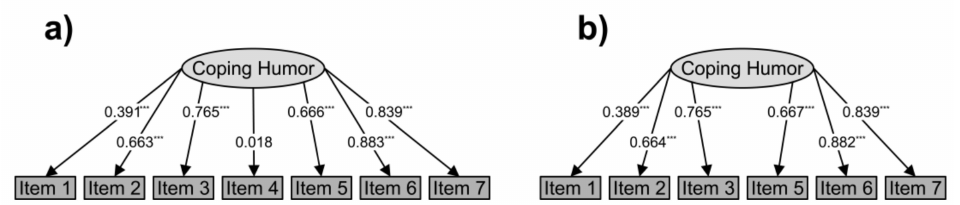
Figure 1. ( a ) Factorial model of the seven-item solution. ( b ) Factorial model of the six-item solution. The digits represent standardized factor loadings. *** p <